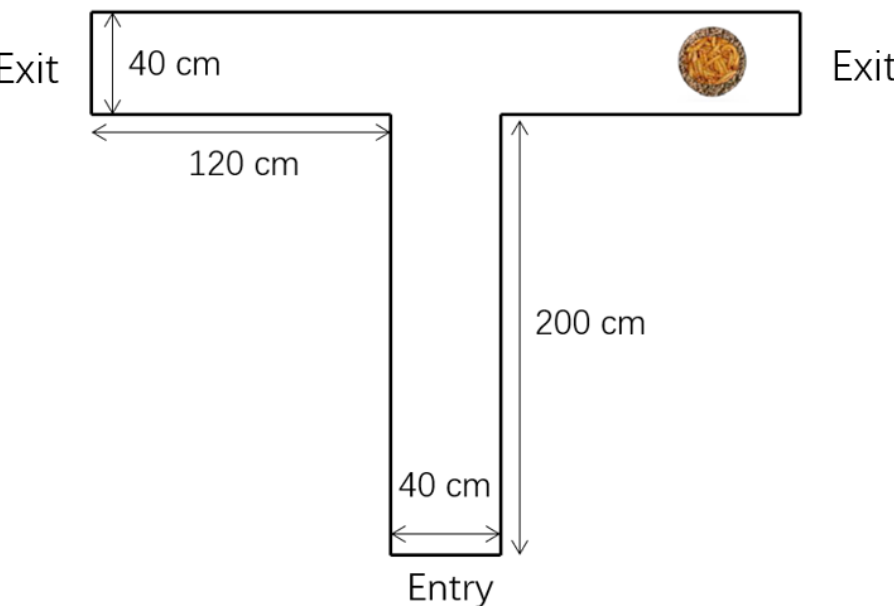
Figure 1. Dimensions of the T-maze. Height of the T-maze: 100 cm.